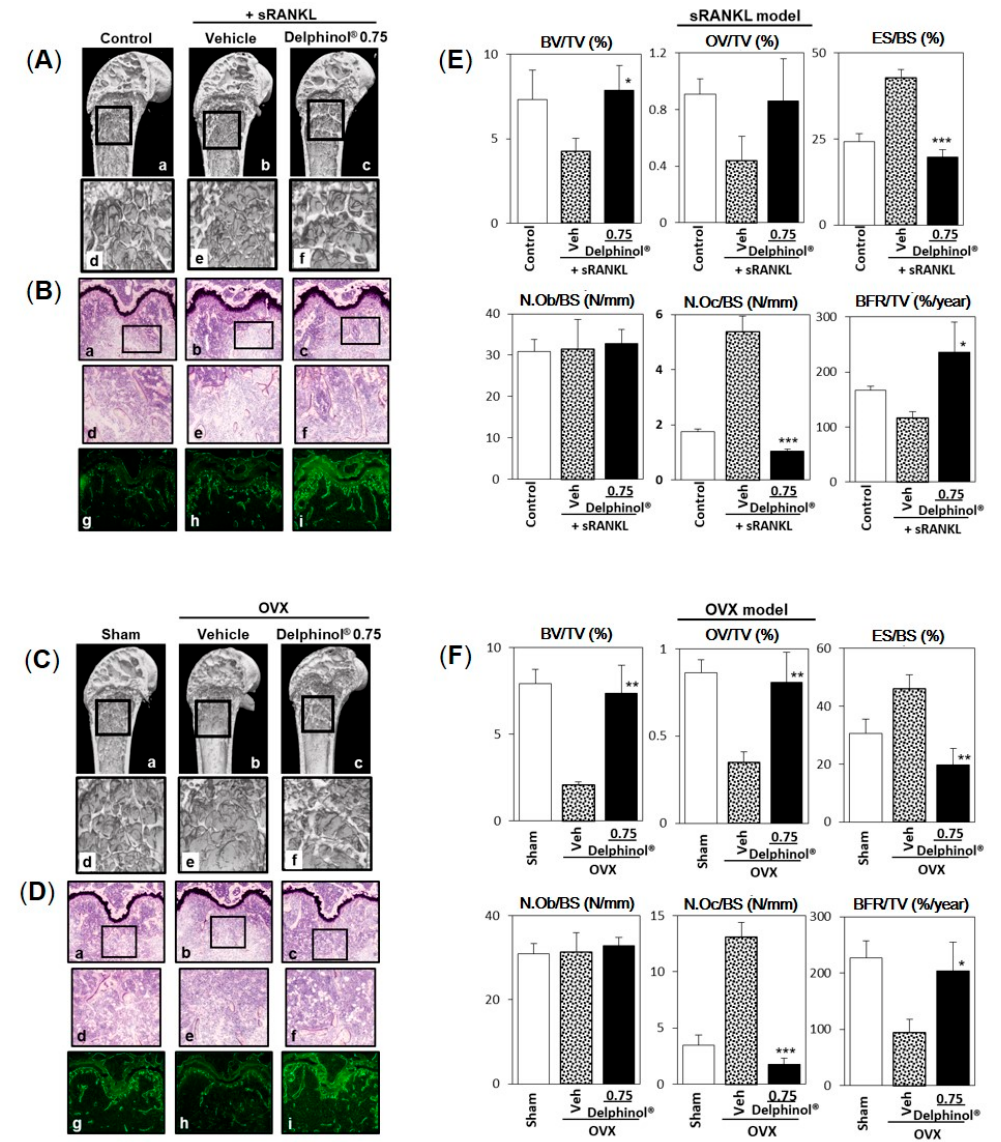
Figure 7. Histomorphometrical analyses of effect of Delphinol ® on bone loss in sRANKL-induced and OVX-induced osteopenic mouse models. ( A ) Representative three-dimensional micro-CT images of the sagittal midsection of distal end of femurs in intact mice (Figure 7Aa and 7Ad, control), sRANKL-induced osteopenic mice (Figure 7Ab and 7Ae, vehicle), and Delphinol ® 0.75 (mg/mouse/day)-administered sRANKL-induced osteopenic mice (Figure 7Ac and 7Af). ( C ) Representative micro-CT images of the sagittal midsection of distal femurs in sham-operated mouse (Sham), OVX-induced osteopenic mouse (vehicle), and a Delphinol ® 0.75 (mg/mouse/day)-treated OVX-induced osteopenic mouse. ( B ) and ( D ) Representative photographs of distal femur sections stained by Villanueva staining in sRANKL- and OVX-induced osteopenic mice, respectively. Figures in the middle panel correspond to the squares in the upper panel. Figures in the lowest panel are fluorescent (calcein) images of the same field of Villanueva staining. ( E ) and ( F ) Histomorphometric parameters were determined by morphometric analyses of fluorescent (tetracycline and calcein)-labeled femurs according to the methods of the ASBMR Histomorphometry Nomenclature Committee [44]. Values are expressed as mean ± SD ( n = 5).; Significance was tested between vehicle and 0.75 mg/mouse/day Delphinol ® . * p < 0.05, ** p < 0.01, *** p < 0.001.